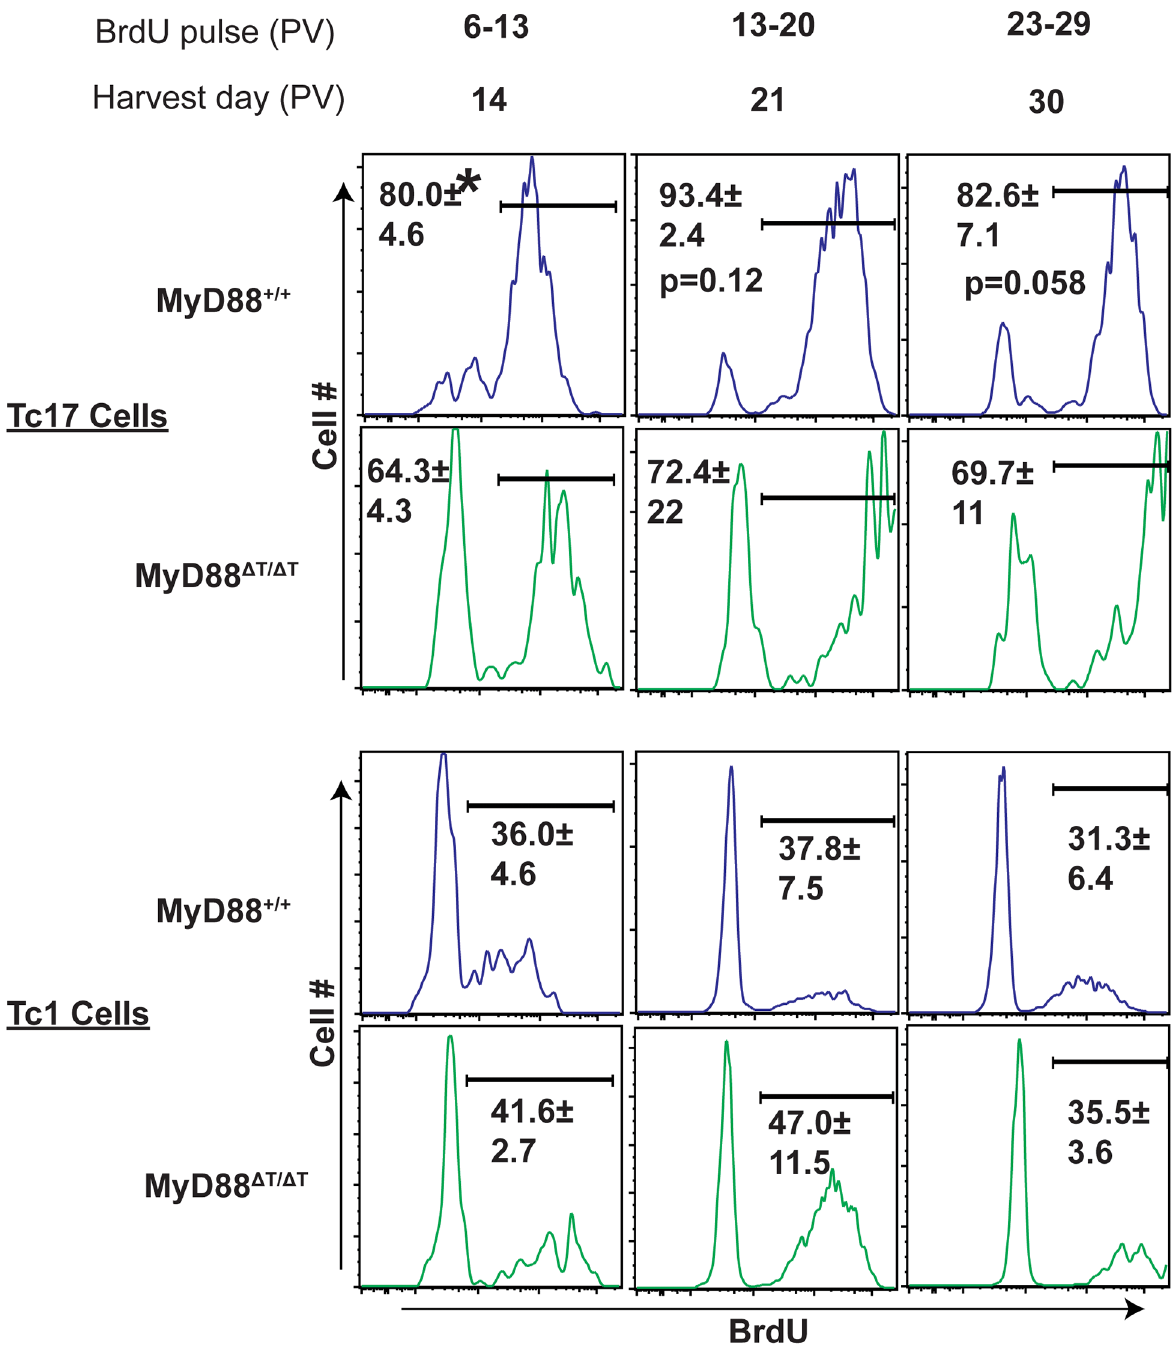
Fig 5. MyD88 signaling potentiates proliferation of Tc17 cells. Na ï ve WT or MyD88 Δ T mice were CD4 + T cell depleted and vaccinated with strain #55. BrdU was pulsed through the drinking water on indicated interval days. Mice were sacrificed and dLNs were harvested at the end of each indicated pulse period. Cells were restimulated, stained for surface and intracellular cytokines before BrdU staining. Percent BrdU +ve cells were analyzed by flow cytometry by gating on CD8 + IL-17- or IFN γ -producing cells. CD4 + T cells were depleted throughout the experiment. Values are percent mean ± SD of 4 – 5 mice/group. * P (cid:1) 0.05. Data is representative of 3 independent